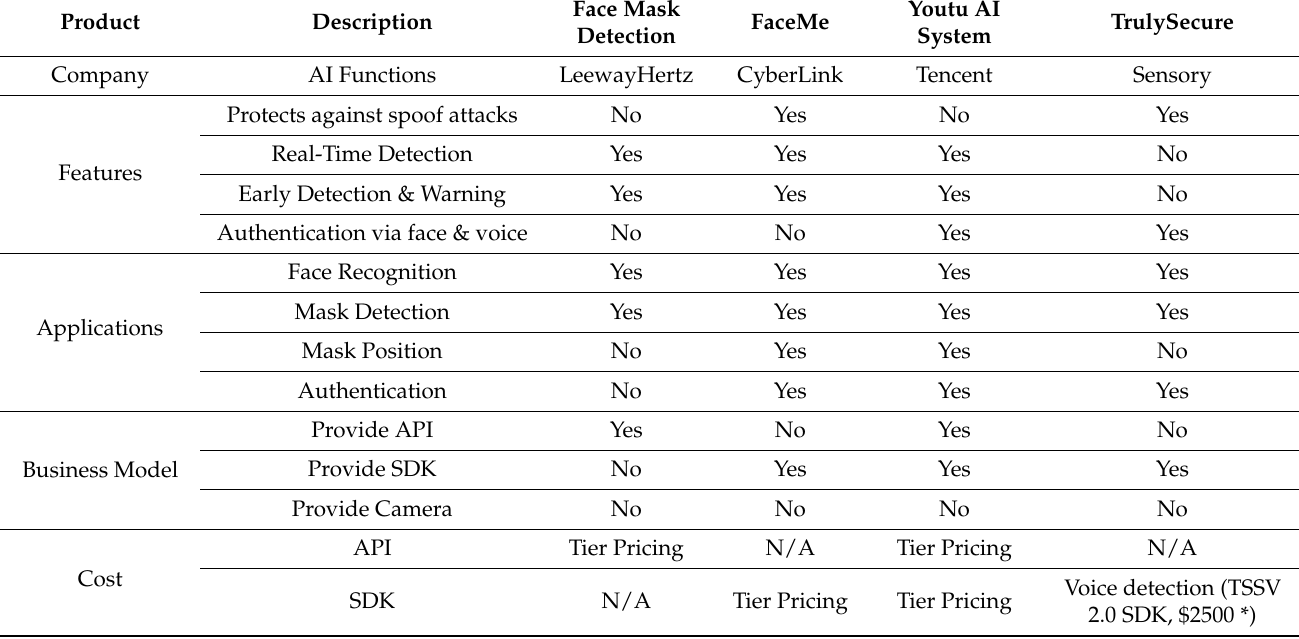
Table 2. Technology